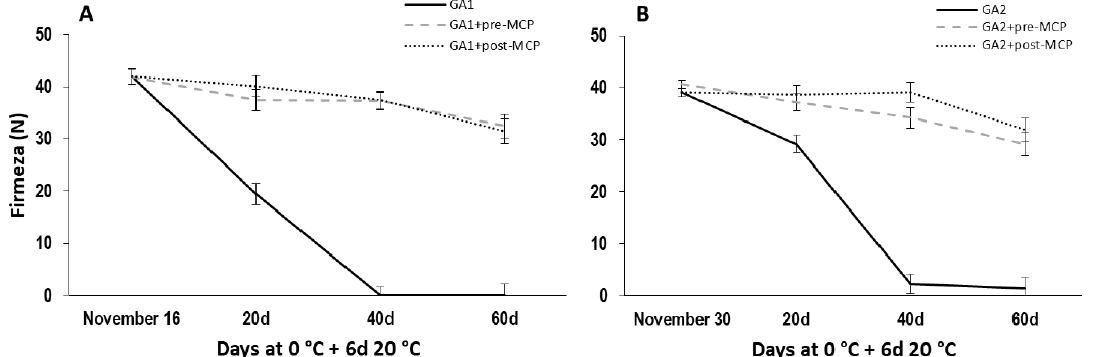
Figure 3. Flesh firmness of the ‘Rojo Brillante’ persimmon treated with 1-MCP during preharvest (pre-MCP), postharvest (post-MCP) or not treated, during cold storage up to 60 d plus a 6-day shelf life at 20 °C. GA1 is the fruit treated once with gibberellic acid ( A ) and GA2 is that treated twice with gibberellic acid ( B ). Vertical bars denote the least significant differences (LSD) intervals ( p ≤ 0.05).